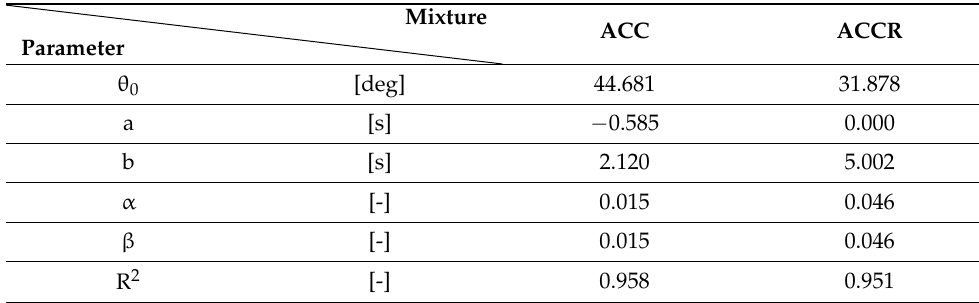
Table 5. Parameters of phase angle master curve θ , Equation